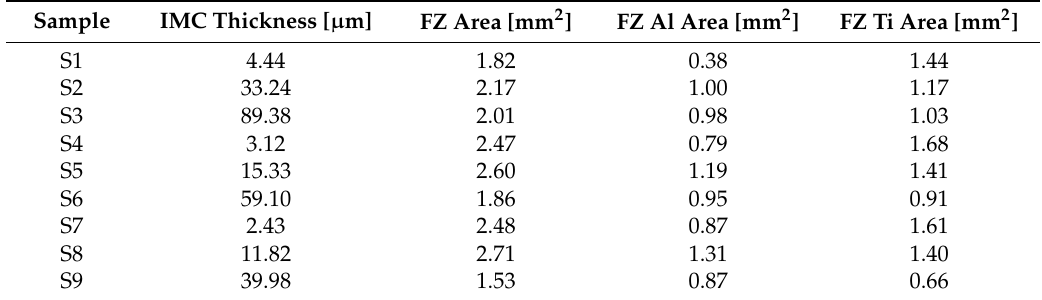
Table 5. IMC layer thickness and fused zone dimensions (see Table 3 for process